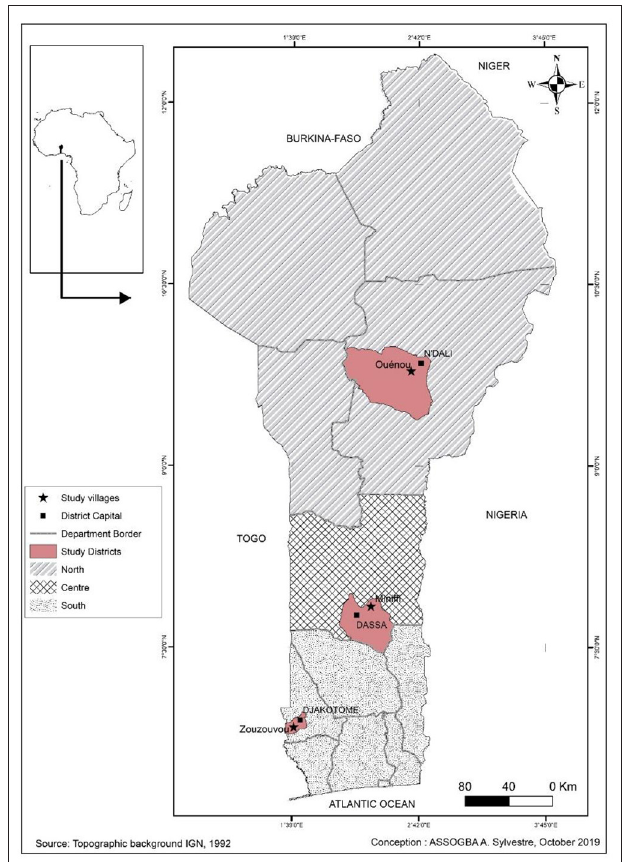
FIGURE 1 | Geographic location of experimental